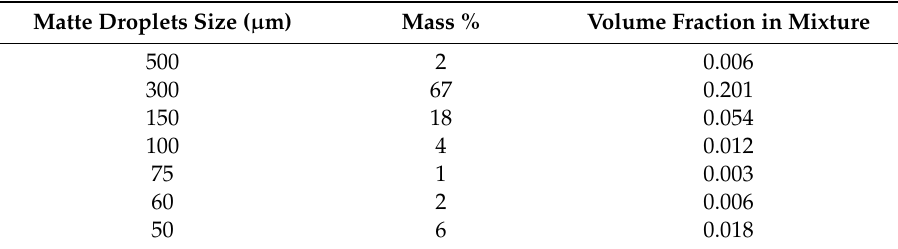
Table 2. Size distribution of the droplets at the